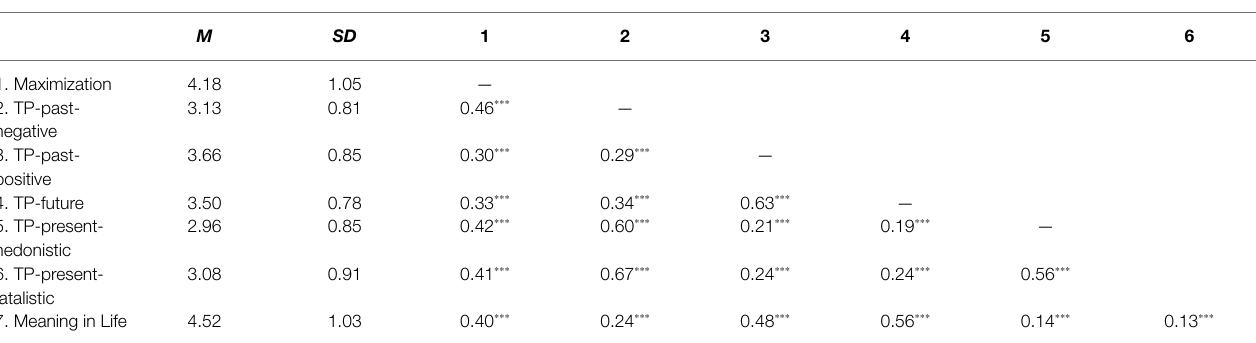
TABLE 1 | Descriptive statistical results of the